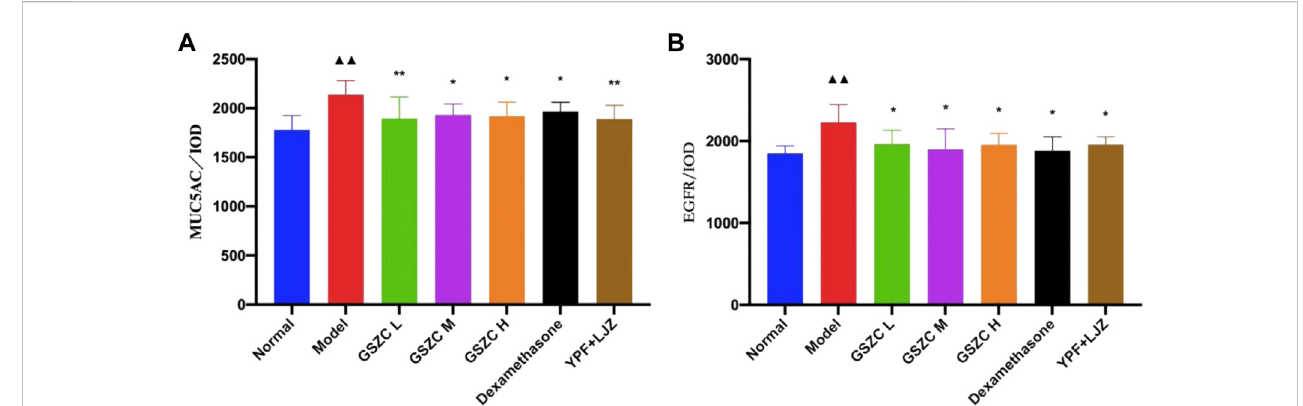
FIGURE 8 Effects of GSZC granules on lung MUC5AC (A) , EGFR (B) mRNA expression in rats suffering from asthma. Values are the mean ± SD, n = 6 for each group. ▲▲ p < .01 versus the normal group, ** p < .01 versus the model group.